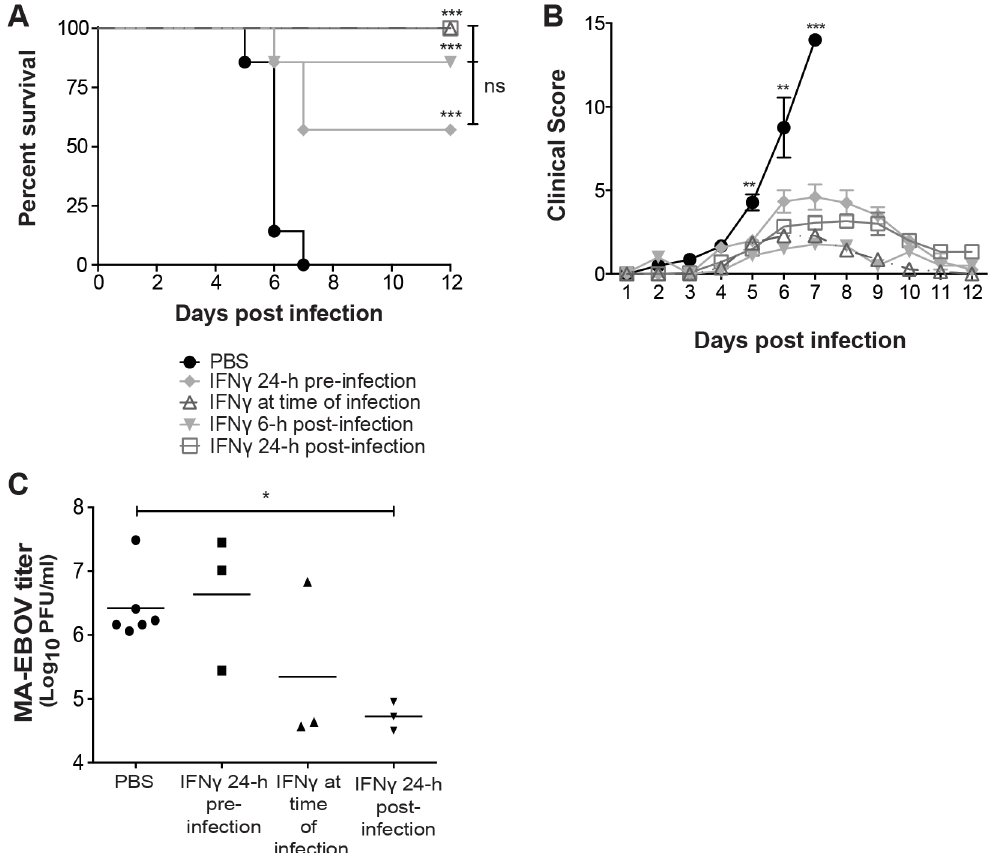
Fig 6. IFN γ protects mice from EBOV morbidity and mortality. (A) IFN γ protects mice from lethal MA-EBOV infection. IFN γ (10 μ g) or PBS was administered by i.p. injection to BALB/c mice 24 hours prior to, at the time of infection, 6 or 24 hours following infection (n (cid:1) 7/treatment). Significance was determined by Mantel-Cox Test, ** p < 0.01, *** p < 0.001. ns, not significantly different. (B) IFN γ treatment reduces MA-EBOV morbidity. Results represent mean clinical sickness scores ± s.e.m (n (cid:1) 7/treatment). Significance was determined by Student ’ s t-test compared to PBS control. (C) IFN γ treatment significantly reduces MA-EBOV viremia in mice treated 24 hours following infection. Serum was collected 4 days following infection (n = 3 – 6 mice/treatment) and serial dilution of sera on Vero-E6 cells to assess plaques formed determined viremia titers. Results represent means ± s.e.m. Significance was determined by Mann-Whitney test compared to PBS control, * p < 0.05.